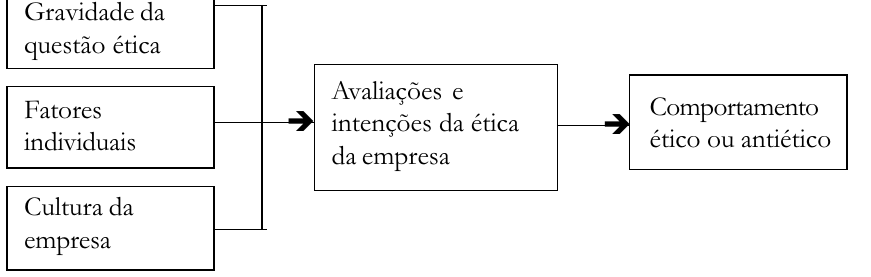
Figura 1. Modelo estrutural para compreender as tomadas de decisªo Øtica na